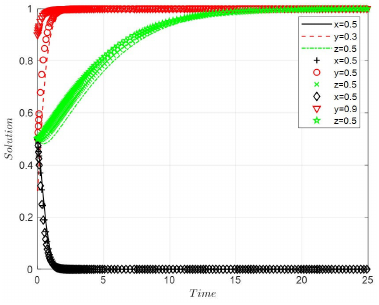
Figure 3. The evolutionary path of scenario 3.